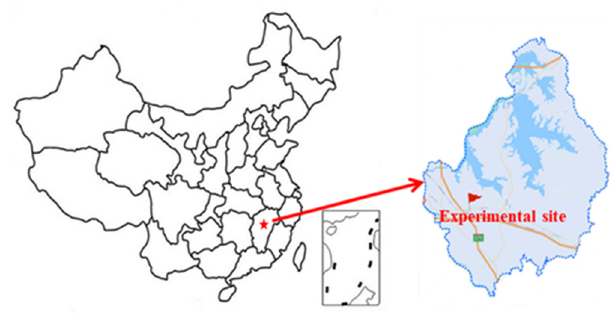
Figure 1. Location of the experimental site.